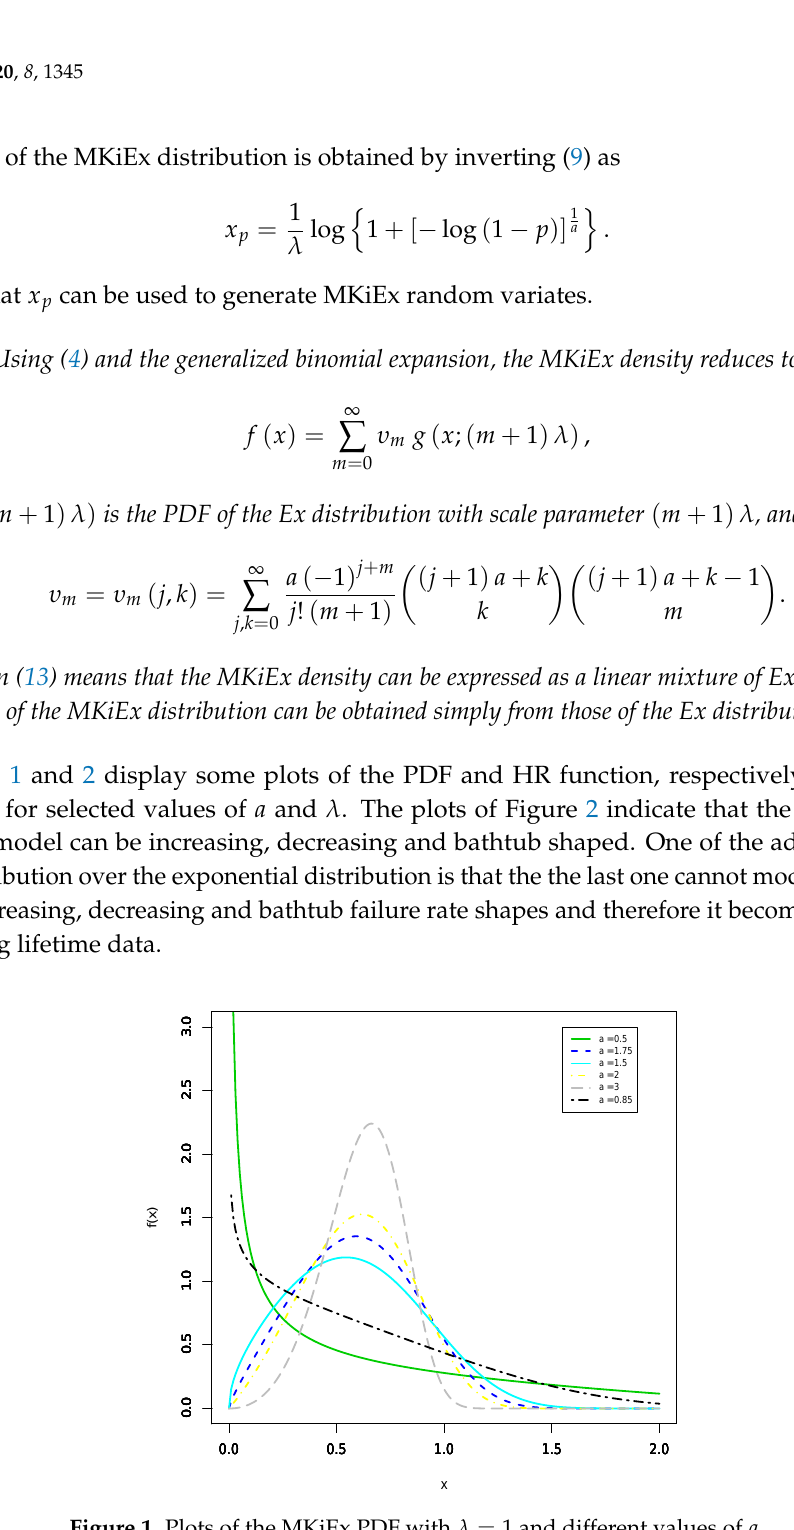
Figure 1. Plots of the MKiEx PDF with λ = 1 and different values of a